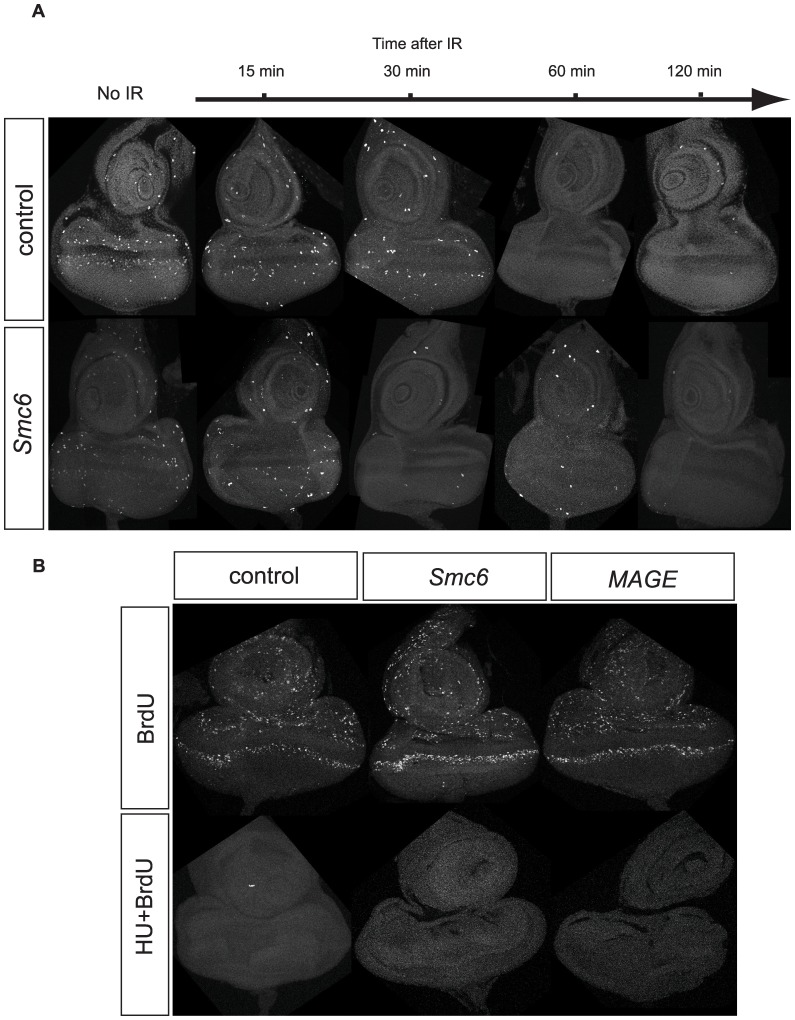

Smc5/6 genes are not required for G2/M and S phase checkpoints induced by genotoxic agents.(A) Wandering third instar larvae were irradiated with 40 Gy of ionizing radiation and the eye-antenna discs were dissected and fixed 15 minutes, 30 minutes, 1 hour or two hours after radiation, with discs from unirradiated larvae serving as controls. Representative images of PH3 staining for mitotic cells in eye-antenna discs from control (WT, FRT82B) and Smc6, (jnjR1/jnjX1) transheterozygous larvae are shown. (B) Eye-antenna discs from wandering third instar larvae were incubated with or without HU before adding BrdU to the incubation solution. Representative images of BrdU staining for cells in S phase in eye-antenna discs from control (WT, FRT82B), transheterozygous Smc6 (jnjR1/jnjX1) or transheterozygous MAGE (sstRZ/sstXL) eye-antenna discs are shown.